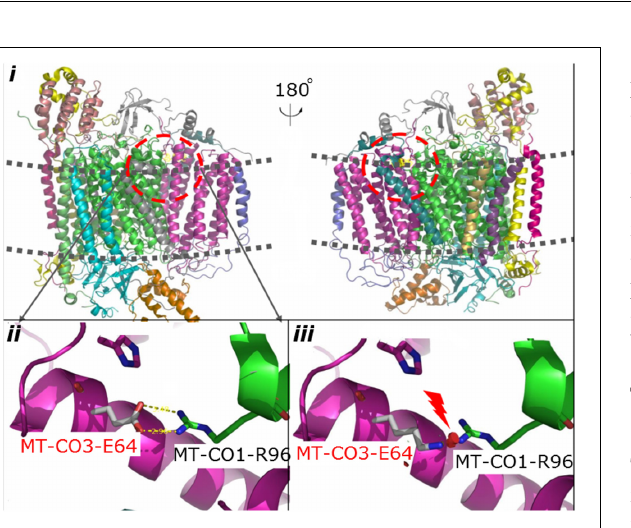
FIGURE 2 | Molecular genetic assays. (A) Family pedigree of the patient (arrow indicates the proband). ND, not detected. (B) Phylogenetic conservation of the human MT-CO3. Arrow, p.64E > K.